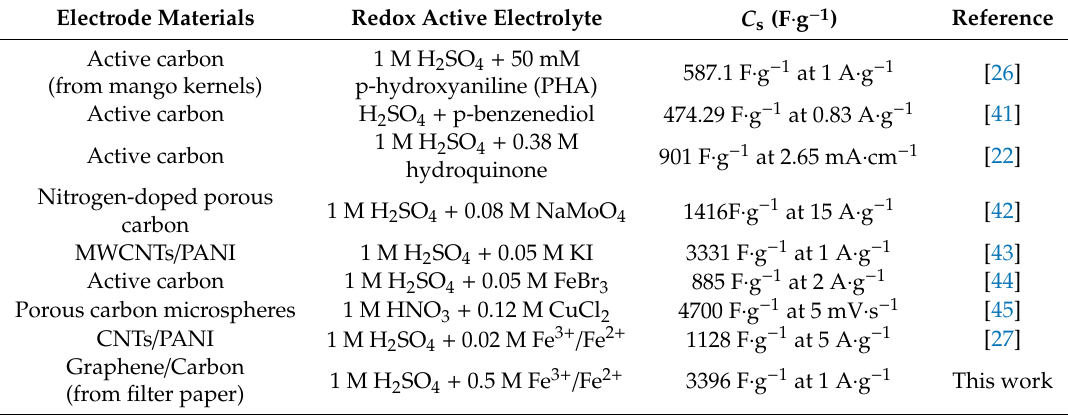
Table 1. Comparison of specific capacitance ( C s ) of carbon based electrodes in redox active electrolyte. Electrode